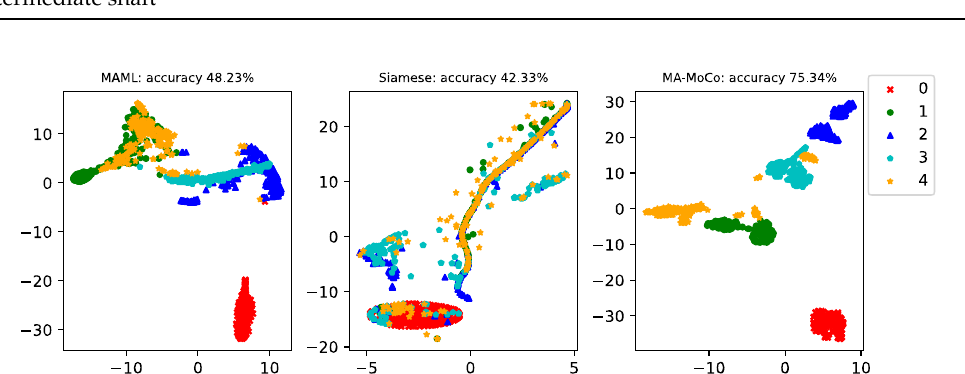
Figure 7. A 5-way 1-shot diagnosis of the generator bearing data when the training set of each class has only 5 fault samples.